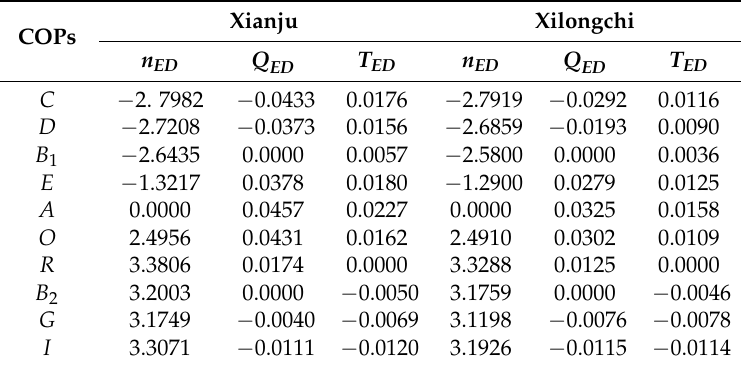
Figure 9. Comparisons of the predicted and measured OOC. ( a ) n ED − Q ED of OOC of the Xianju pump-turbine; ( b ) n ED − T ED of OOC of the Xianju pump-turbine; ( c ) n ED − Q ED of OOC of the Xilongchi pump-turbine; ( d ) n ED − T ED of OOC of the Xilongchi pump-turbine. Table 4. The characteristic parameters of COPs on OOC.